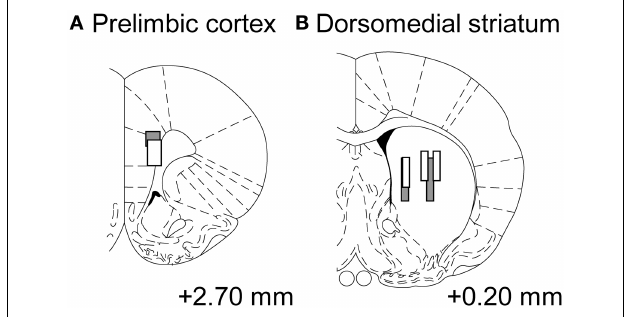
FIGURE 7 | Tracks of electrode bundles. Each diagram shows a coronal section referenced to the bregma (Paxinos and Watson, 1997). Data recoding from the sites (A,B) were treated as neuronal activities from the prelimbic cortex and dorsomedial striatum, respectively. Gray-level of boxes distinguishes electrode tracks from each